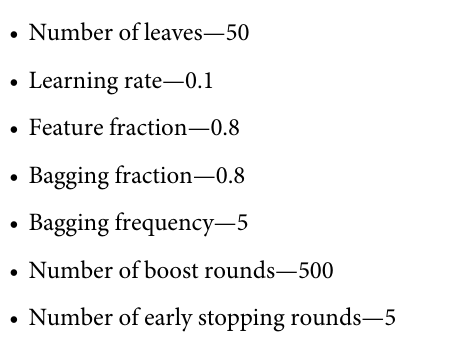
S1 Fig. Multiple barcodes, and randomized control for RNA abundance and splicing efficiency. A. Histogram of total splicing efficiency values. Only variants with splicing efficiency > 0 are presented. B. Splicing efficiency mean variance of quartets of the same sequence design, with different barcode sequences (red arrow), compared to the